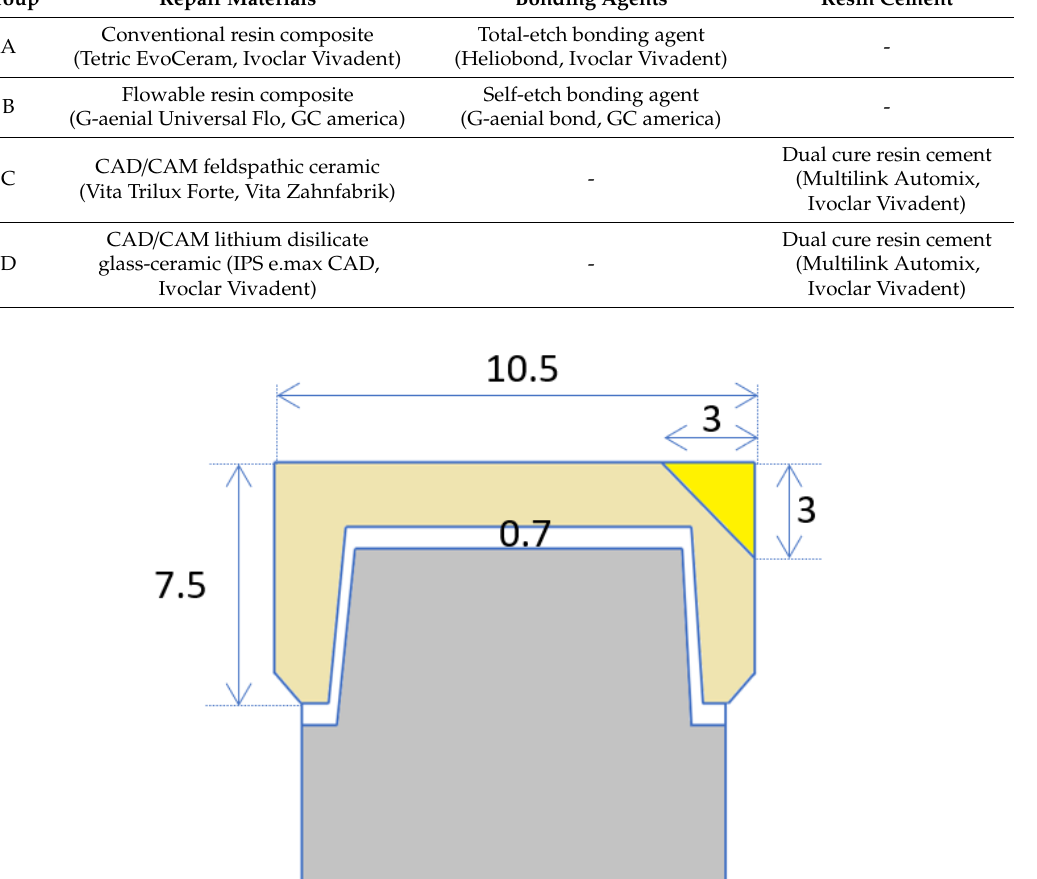
Figure 2. Cross sectional view of specimens with standard dimensions in millimeters. Cutting plane containing the plane of symmetry of the repaired part and the cylinder axis. containing the plane of symmetry of the repaired part and the cylinder axis.